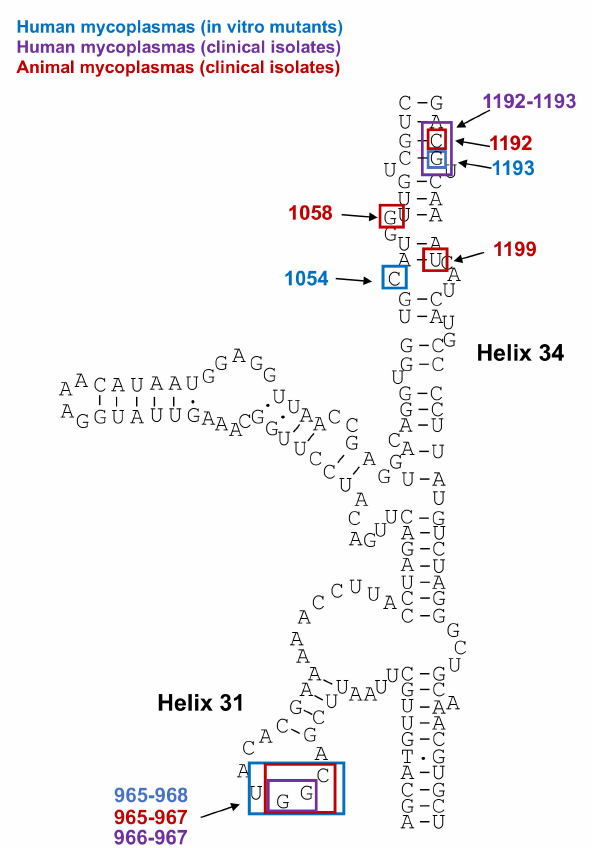
Figure 2. Positions of 16S rRNA mutations associated with tetracycline resistance or loss of suscepti- bility in mycoplasmas ( Escherichia coli numbering)